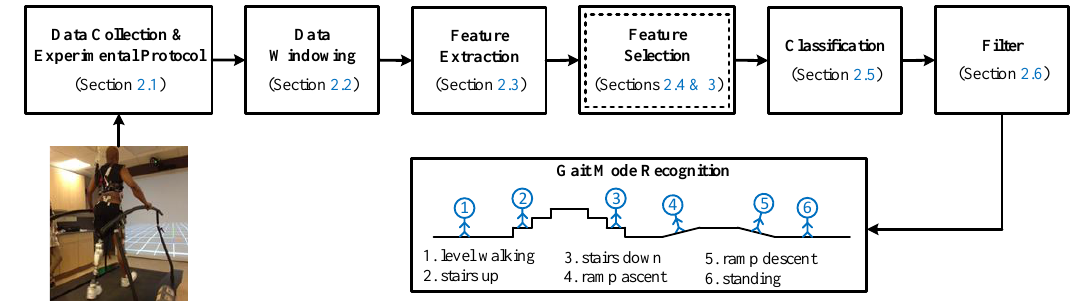
Figure 1. Architecture of user intent recognition system. The double-lined box indicates that an evolutionary algorithm is used for